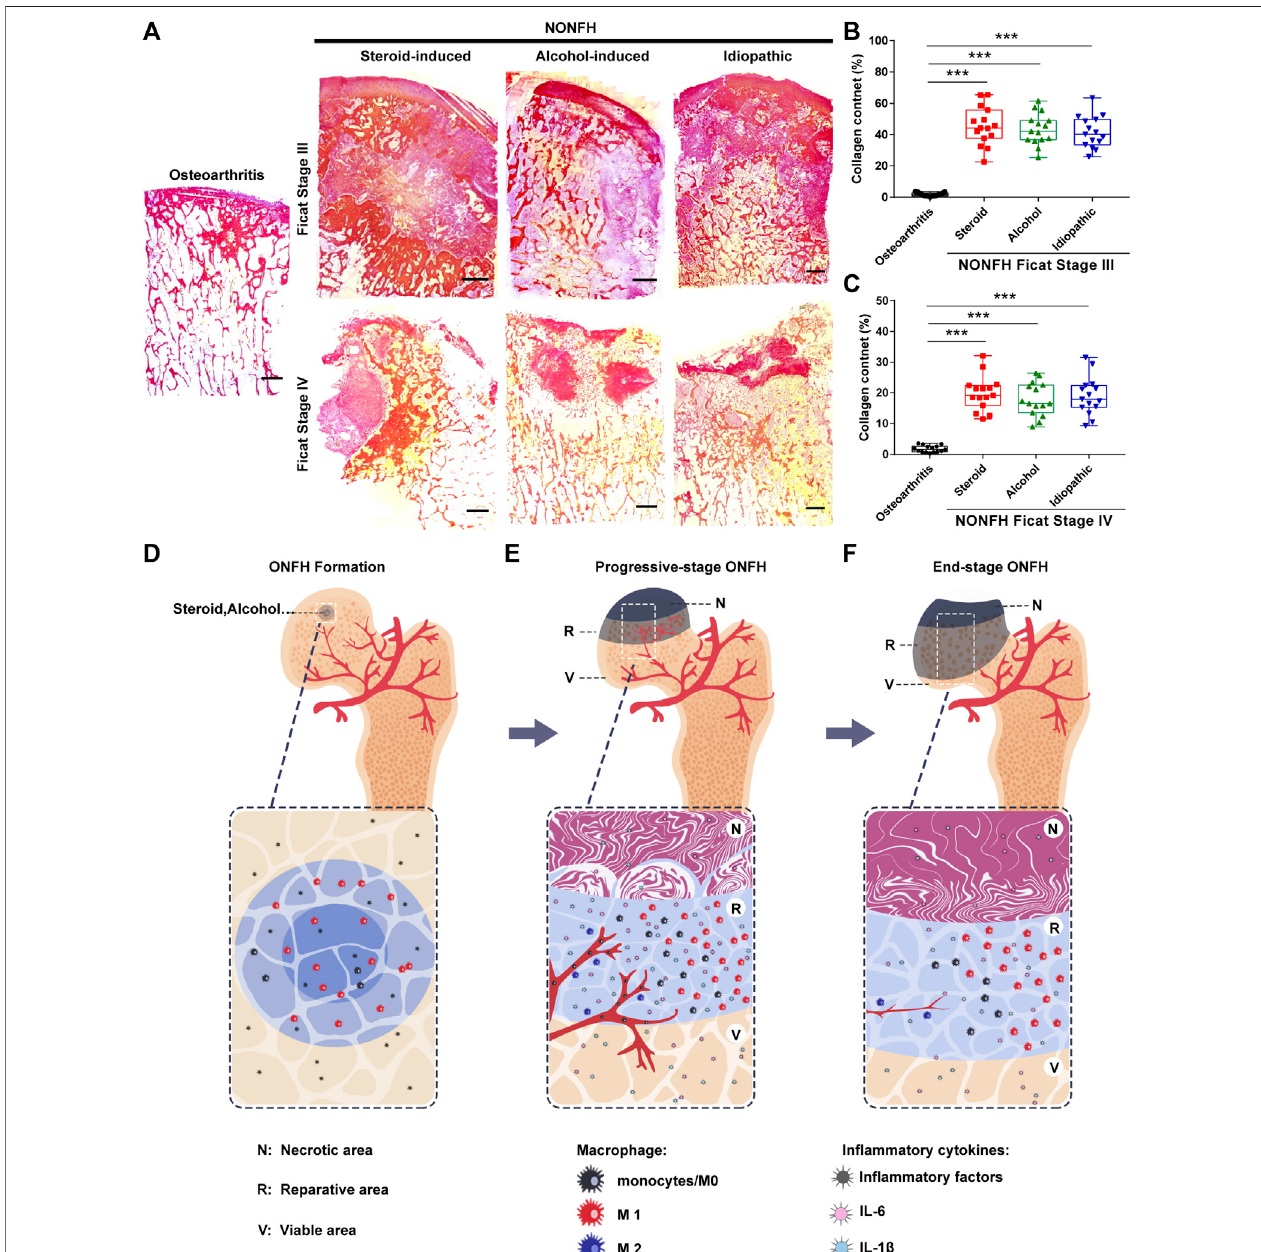
FIGURE5| Fibrous tissue formed and hindered therepair ofnecroticareasinNONFH (A) Representativeimages ofSirius Red-stainedsections from patientswith different types and stages of NONFH. Scale bar, 2.5 mm (B,C) Collagen quanti fi cation in sections from patients with different types NONFH in Ficat Stage III (B) or Ficat stage IV (C) ,basedon Sirius red staining (D – F) Schematic showing howmacrophageM1/M2imbalanceparticipatesintheformationofchronic in fl ammationand tissue fi brosis,andfacilitatestheprogressionofhumanNONFH:macrophagesmigratetothelocalbonelesionandadopttheM1phenotype,thensecreteabundantIL-6, IL-1 β and other in fl ammatory factors after bone necrotic (D) . Those cytokines induce blood vessels formation and recruit monocytes into the local lesion. And then the monocyte/macrophages are polarized to M1 (avascular regions) and M2 (around blood vessel) subtype. The M1 subtype is dominating in local lesion and secreting the in fl ammatory cytokines to formation the in fl ammatory microenvironment (E) . When osteonecrosis progresses to the base of the femoral head (end-stage), in fl ammation subsided, the number of macrophages M1 decreased, bone necrotic with bone formation (F) .